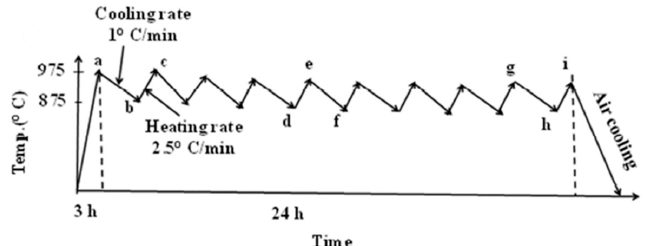
Figure 12. Schematic of the heat treatment employed for a period of 24 h. Reproduced from [96], with with permission of Elsevier, permission of Elsevier, 2019.